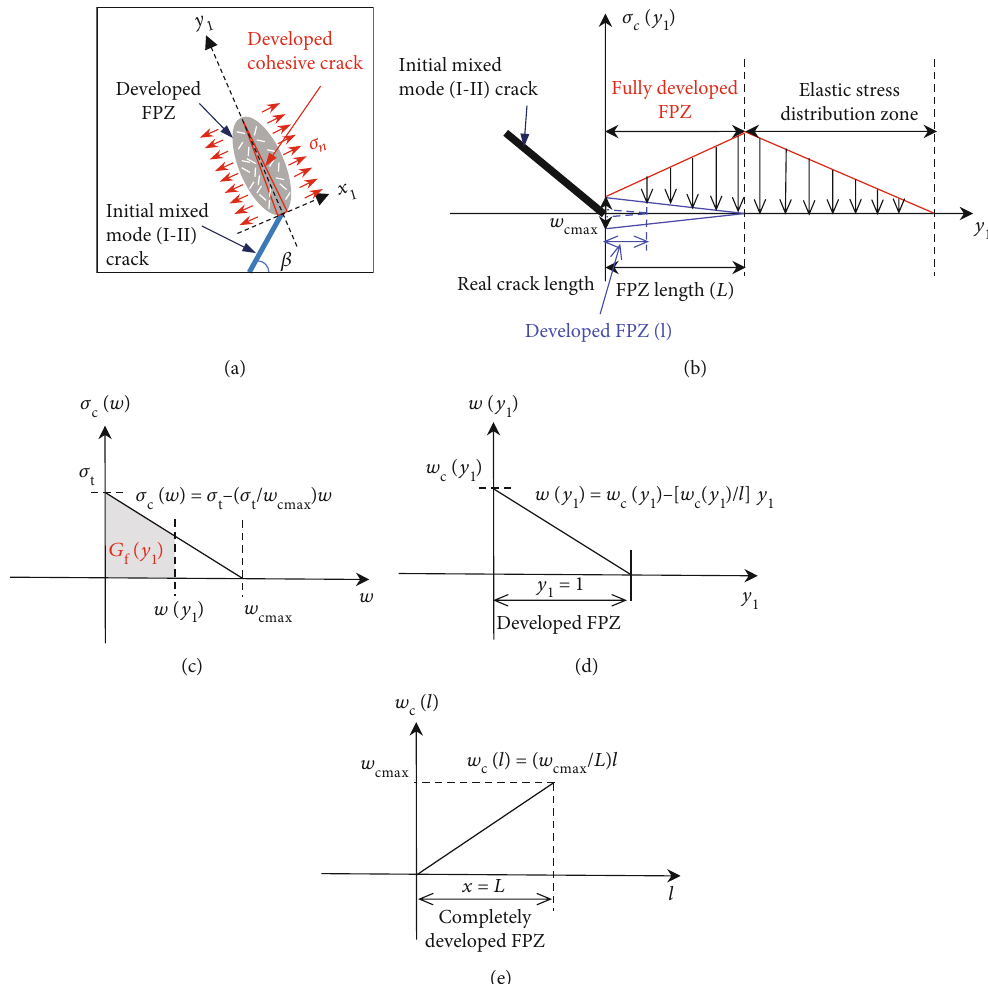
Figure 4: FPZ Development ahead of the mixed-mode (I-II) fracture tip of rock-like materials: (a) schematic diagram of the tensile development of the FPZ under mixed-mode (I-II) stresses; (b) cohesive stresses distributed along the cohesive crack in FPZ, ahead of the mixed-mode (I-II) fracture tip; (c) cohesive stress vs. crack opening displacement; (d) the distribution of crack opening displacement along the cohesive crack (i.e., FPZ); (e) the rising crack tip opening displacement with FPZ development (i.e., the increment of FPZ